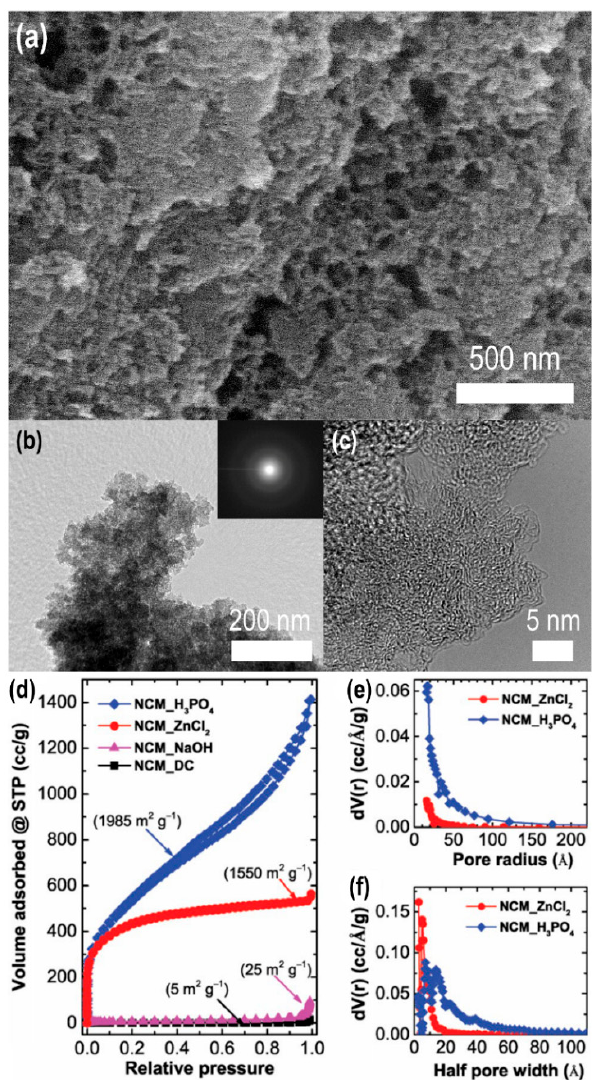
Figure 6. Electron microscopy observation and surface textural properties of activated nanoporous carbon materials (NCM) derived from chemical activation of Areca Catechu Nut. ( a ) SEM, ( b ) TEM and ( c ) HR − TEM images of H 3 PO 4 activated NCM as typical example. ( d ) Nitrogen sorption isotherms of activated sample, for comparison isotherm for NCM_DC (directly carbonized) is also included. ( e ) Pore size distribution curves obtained from Barrett − Joyner − Halenda (BJH) method, and ( f ) Corresponding pore size distribution obtained from density functional theory (DFT) method. Reproduced